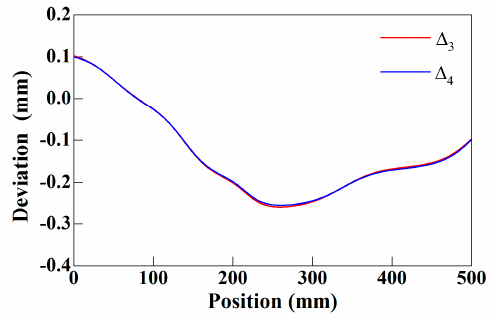
Figure 33. The average of the combined projection curves of the PC and PD surfaces.